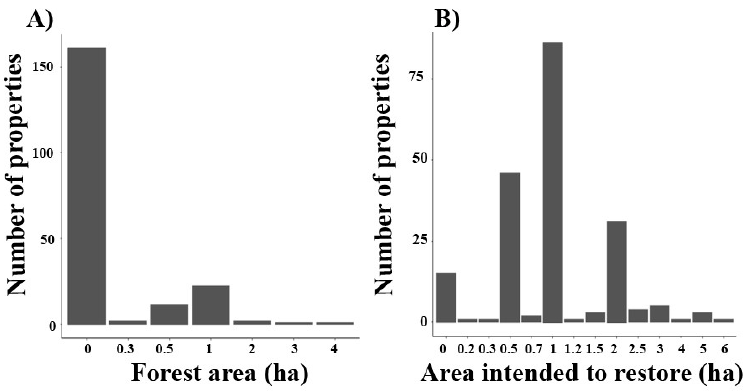
Figure 3. ( A ) Distribution of the Polylepis forest areas in the properties. ( B ) Distribution of the Pol- ylepis forest areas that the families intend to restore in their properties.